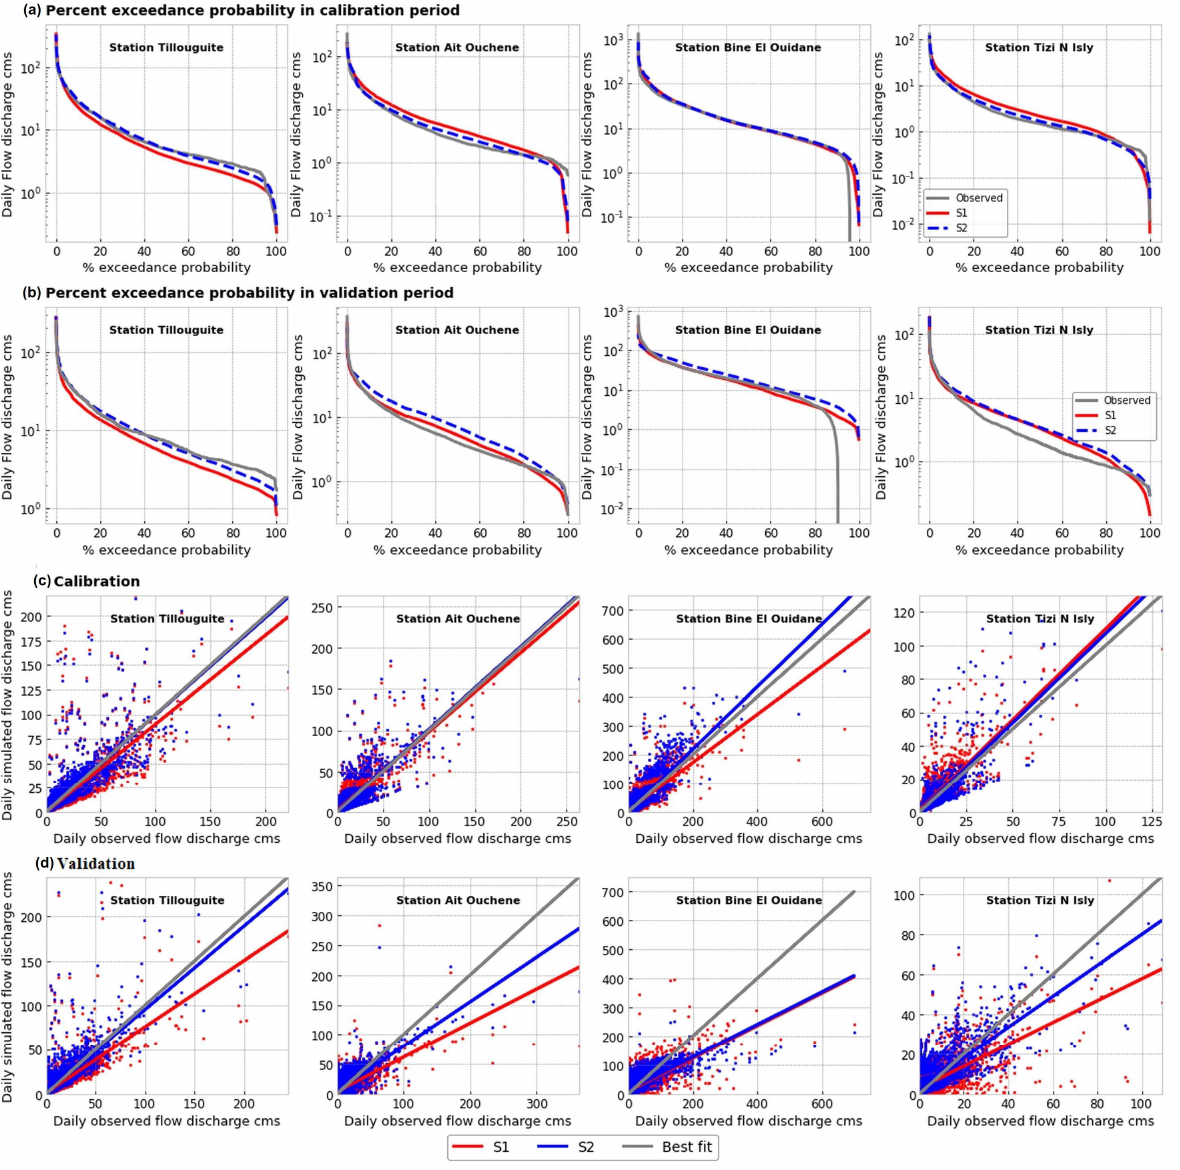
Figure A1. Percent exceedance probability for ( a ) calibration and ( b ) validation period and scatter plot between observations and simulations in ( c ) calibration and ( d ) validation.